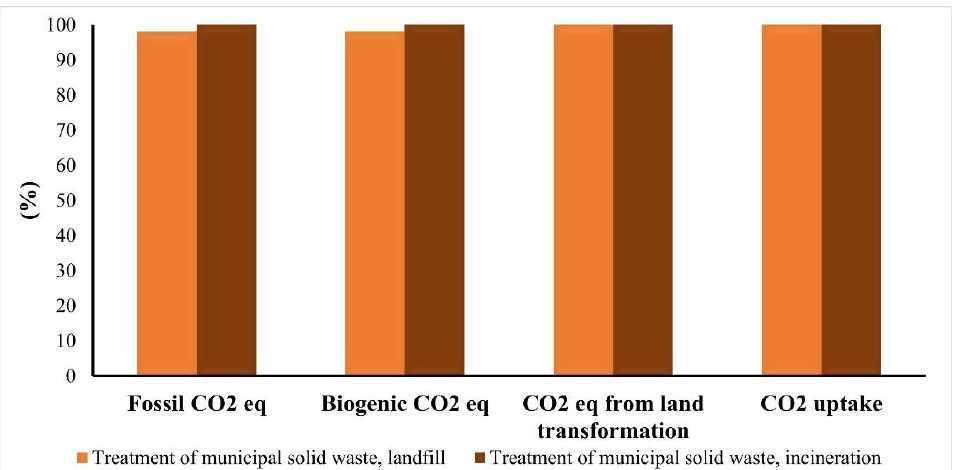
Figure 8. Relative environmental impacts of CD-5 for incineration and landfill disposal scenario, applying Greenhouse Gas Protocol method.